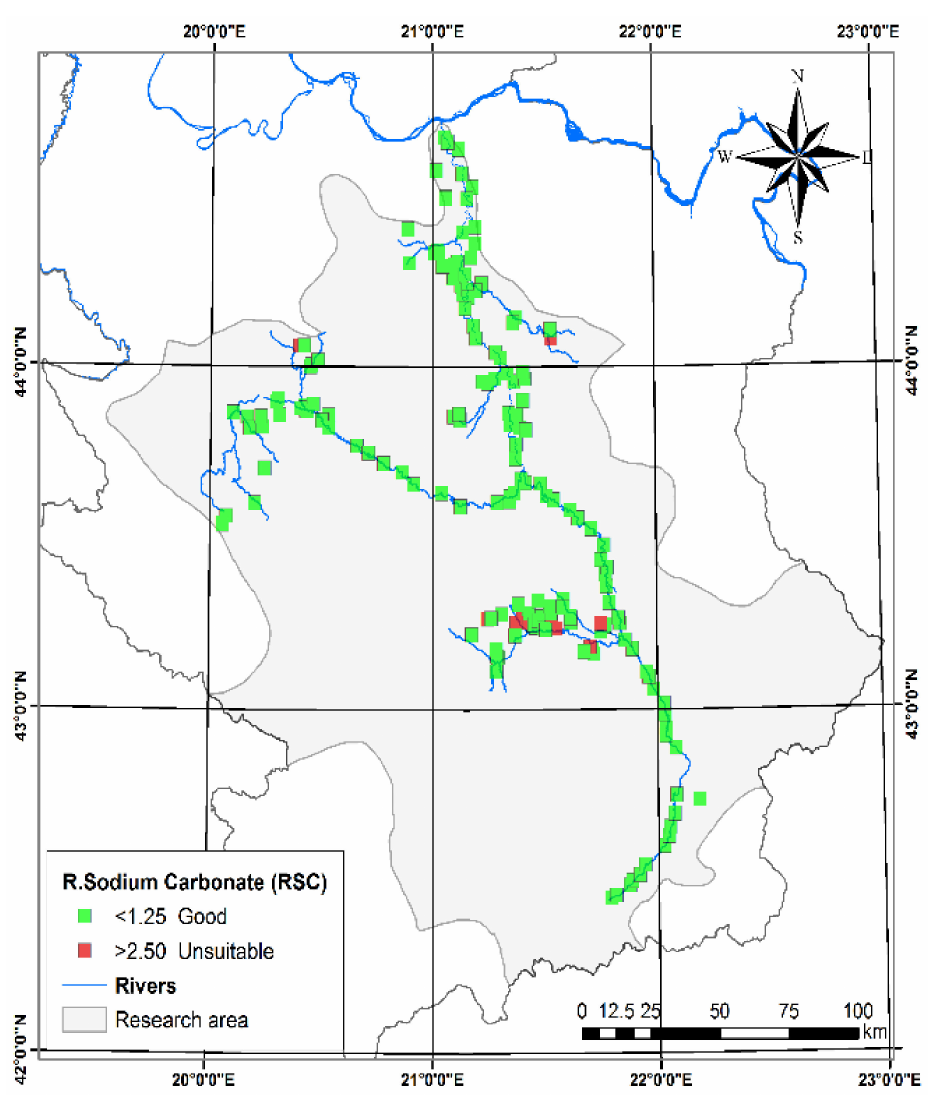
Figure 10. Spatial distribution of